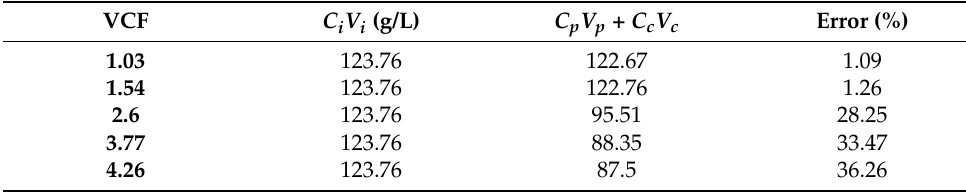
Table 6. The mass balance for the protein removal.